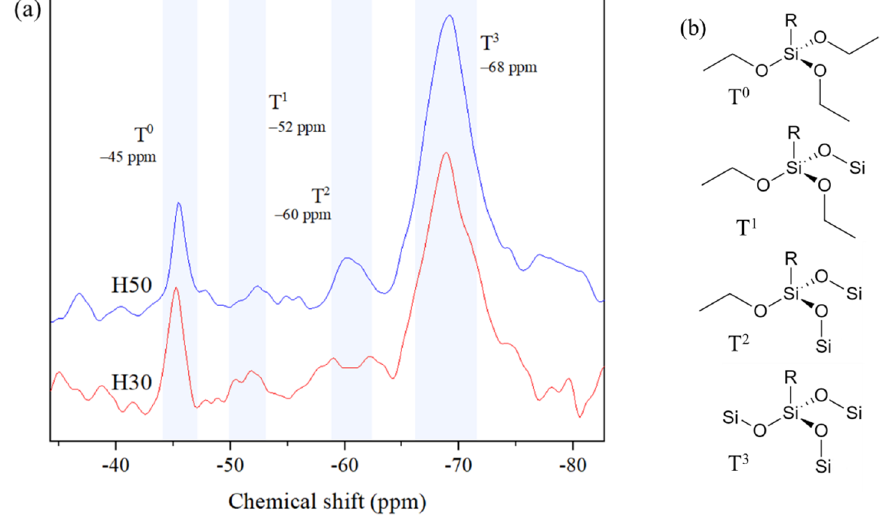
Figure 6. ( a ) 29 Si magic angle spinning (MAS) NMR spectrum of H30 and H50 hybrid films and ( b ) representation of siloxane condensation degrees. Table 2. Glass transition temperatures and weight loss for H0, H30 and H50